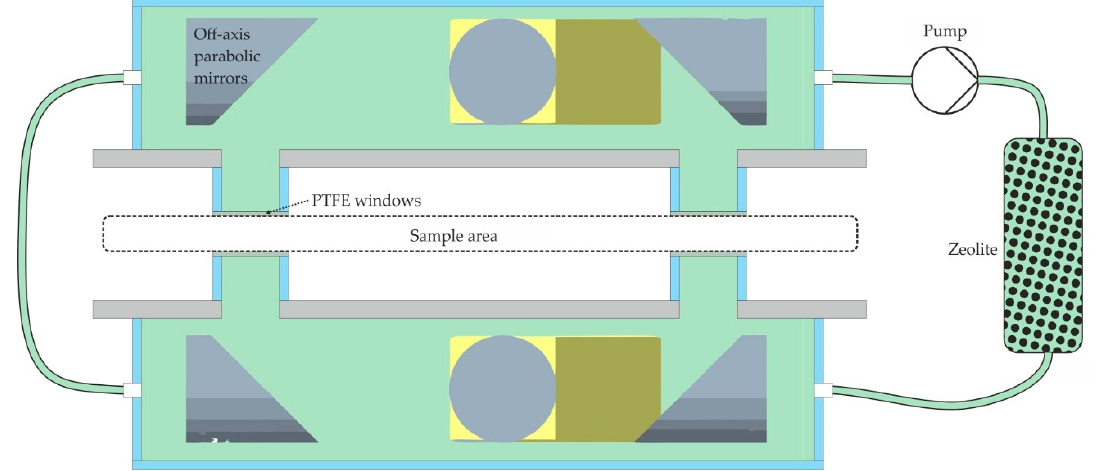
Figure 8. Schematic of the air-drying circuit according to the setup shown in Figure 5. A closed loop containing a zeolite reservoir for air drying is enclosing most of the terahertz beam path. A humidity regulated pump is used to circulate the air and ensuring the interaction of the humid air with the zeolite granulate.